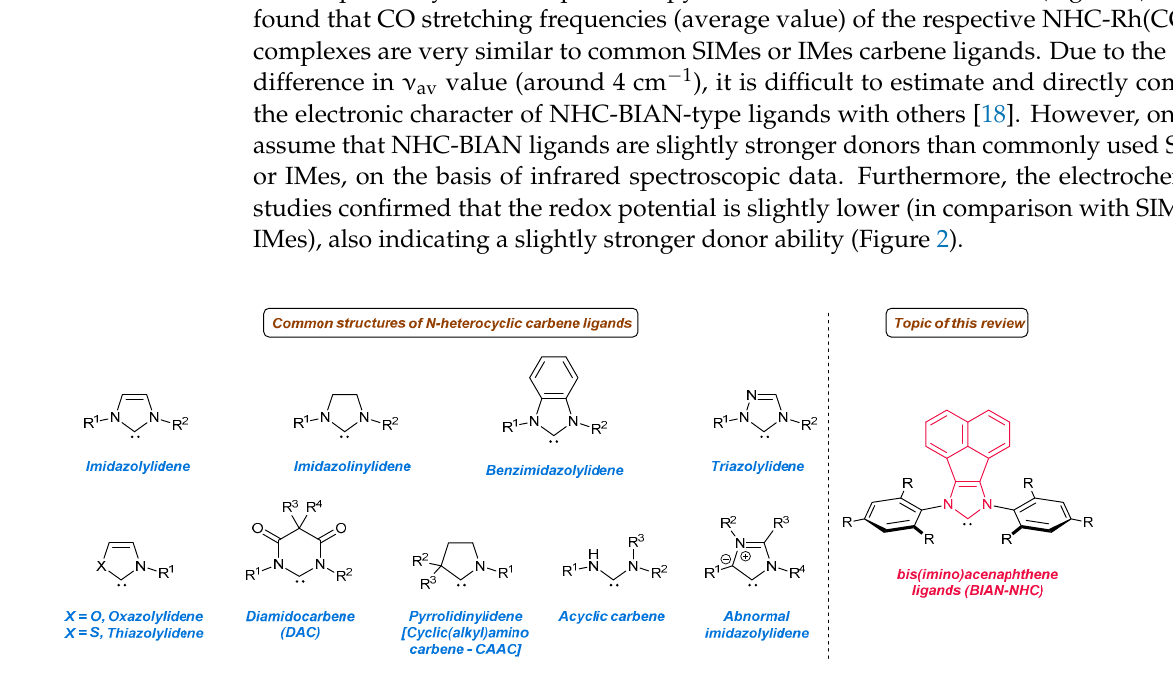
Figure 1. The structure of commonly used NHC and BIAN-NHC ligands.